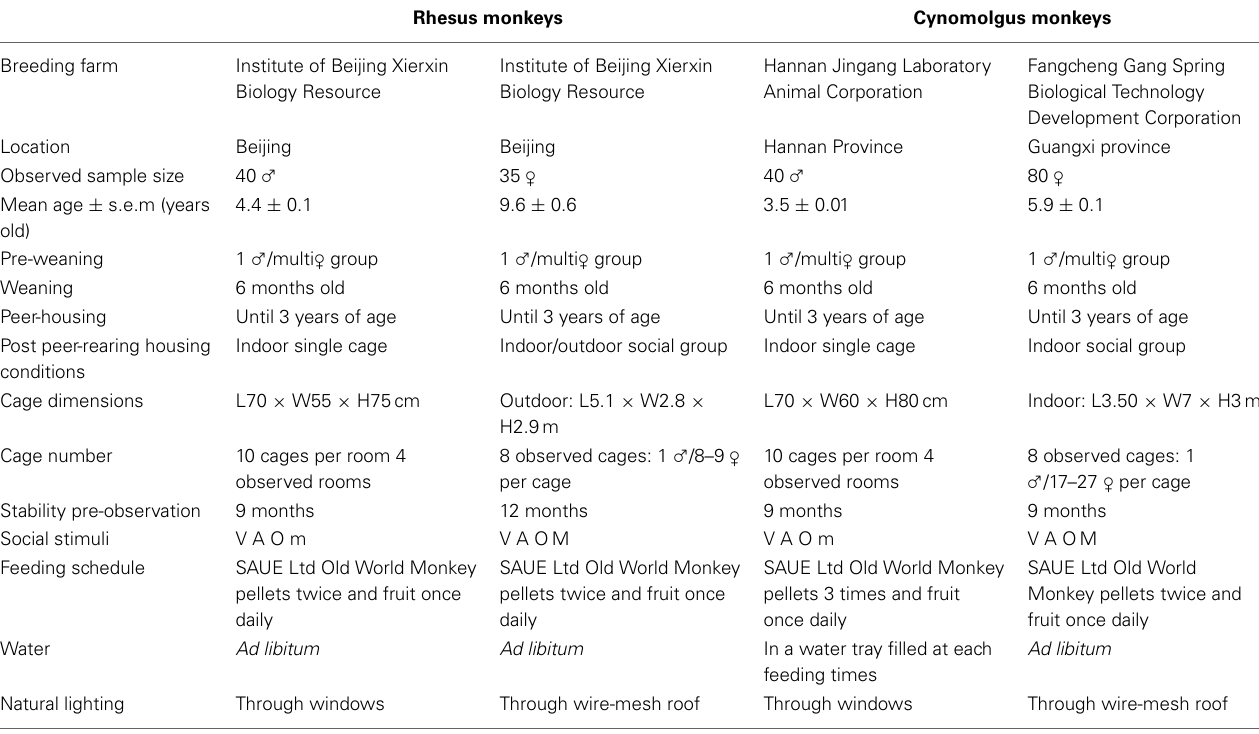
Table 1 | Rhesus and cynomolgus single- and social- housing conditions and animal